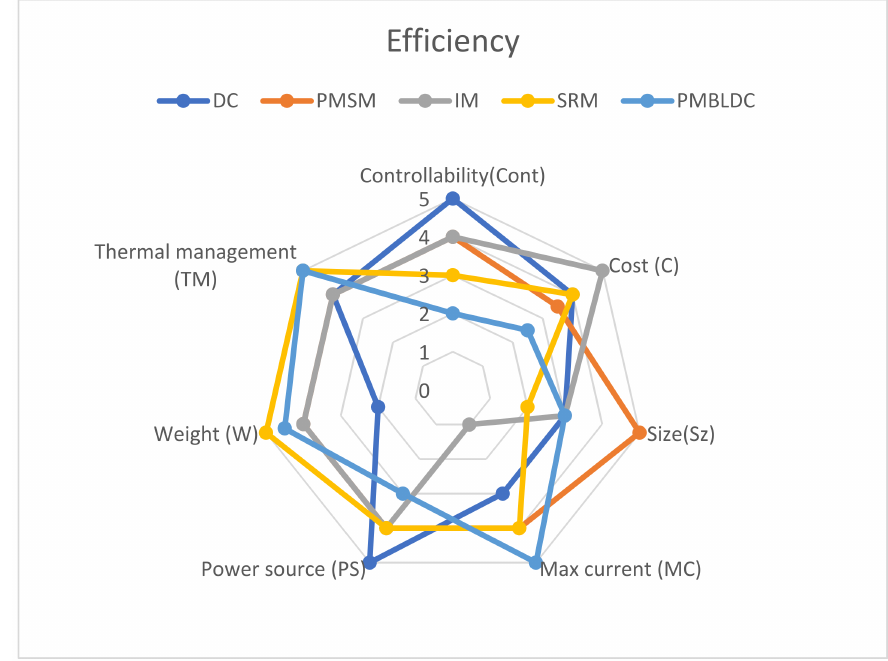
Figure 17. Factors related to the efficiency of electric motors for electric